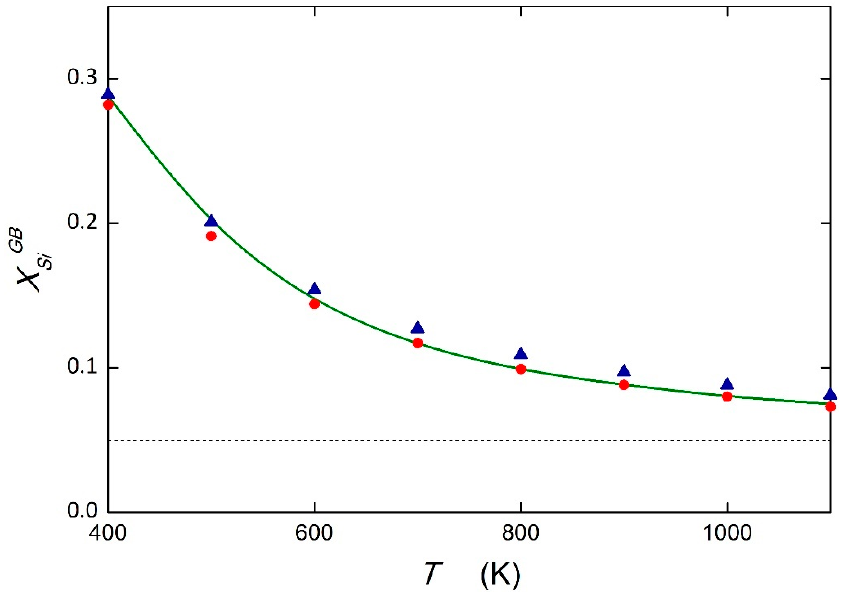
Figure 2. Si concentration at the {013} grain boundary of bcc iron in the temperature range 400–1100 K. The green line represents the averaged concentration obtained from DFT calculations [24], the red points are the values resulting from AES measurements [23], and the blue triangles were estimated on the basis of model [11]. The dotted line corresponds to the bulk concentration, X Si = 5 at.%.